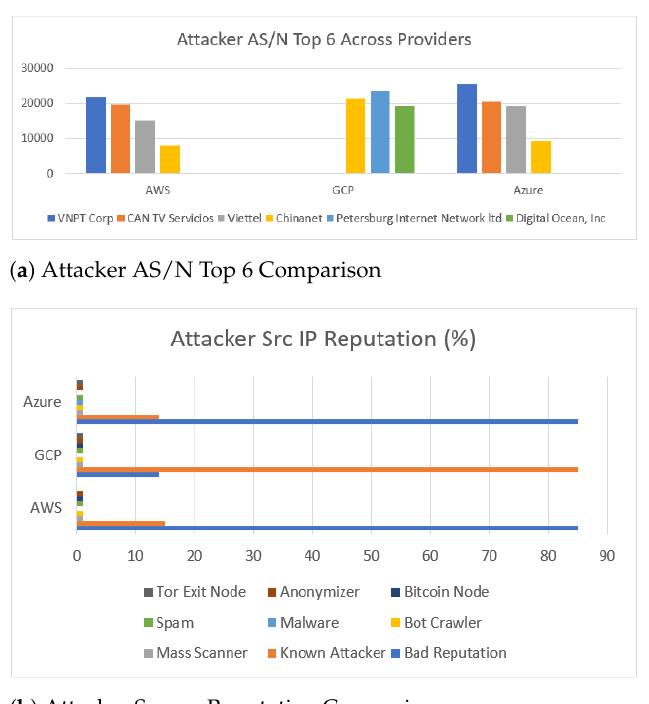
Figure 14. Attacker AS/N Furthermore, Attacker Source Reputation